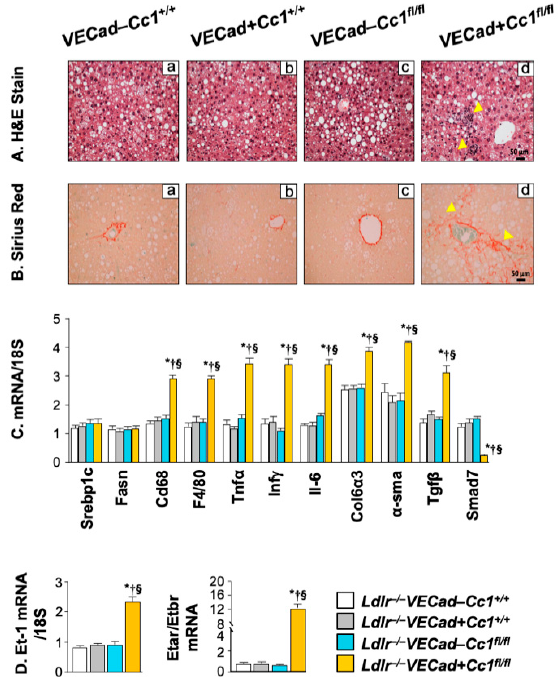
Figure 7. Hepatic inflammation and fibrosis analysis. Livers of littermate mice (n ≥ 5/genotype) fed with HC for 3 months and described in the legend of Figure 2 were extracted and subjected to: ( A ) H&E for histological analysis and ( B ) Sirius Red staining to detect parenchymal inflammatory infil- tration and chicken-wire bridging fibrosis (yellow arrowheads), respectively, in Ldlr − / − VECad+Cc1 fl/fl mice (panel d) but not in their three controls (panel a–c). ( C , D ) qRT-PCR analysis (normalized to 18S) of mRNA levels of hepatic genes involved in lipogenesis, inflammation, and fibrosis. Values were expressed as mean ± SEM. * p < 0.05 vs. Ldlr − / − VECad–Cc1 +/+ , † p < 0.05 vs. Ldlr − / − VECad+Cc1 +/+ , § p